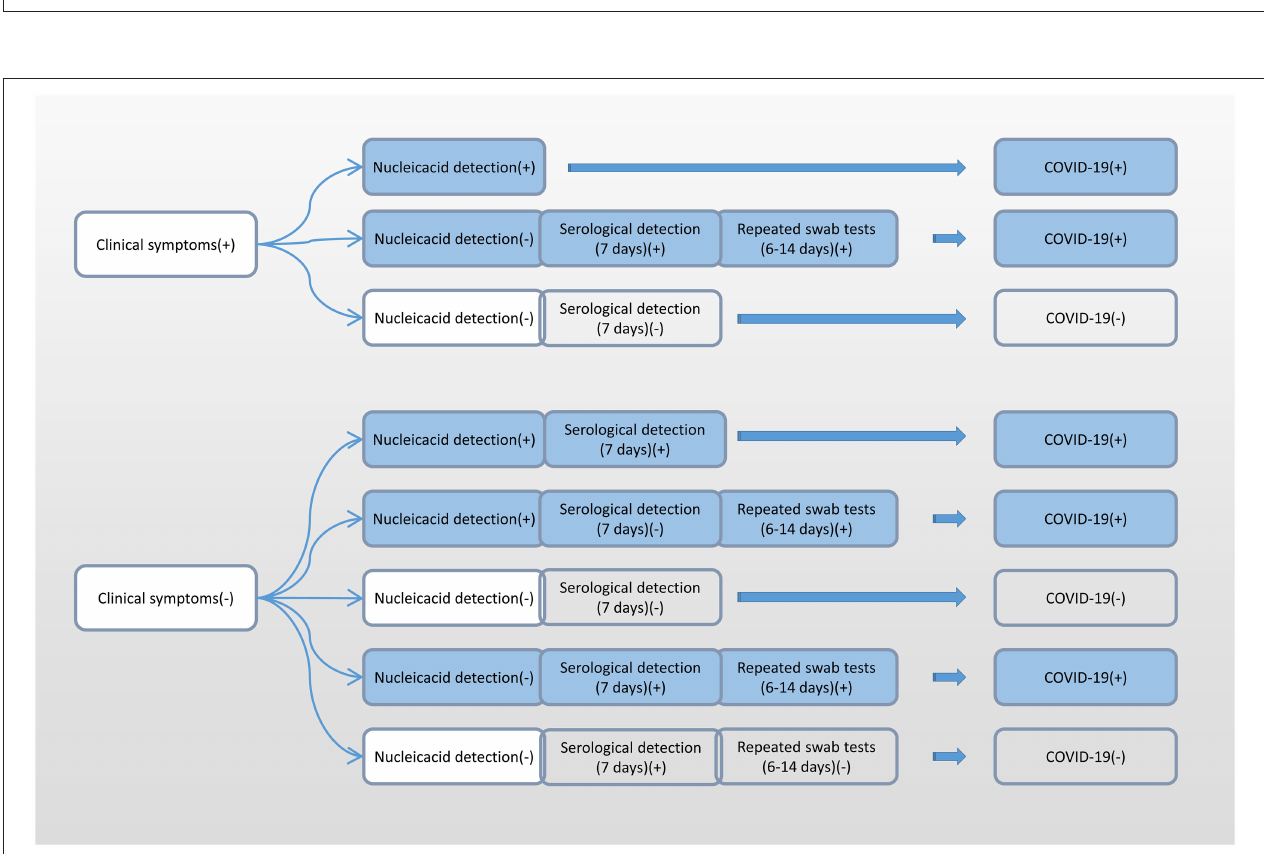
FIGURE 6 | Flow chart of the selection of different detection methods for SARS-CoV-2 at different infection periods. SARS-CoV-2, severe acute respiratory syndrome coronavirus 2.